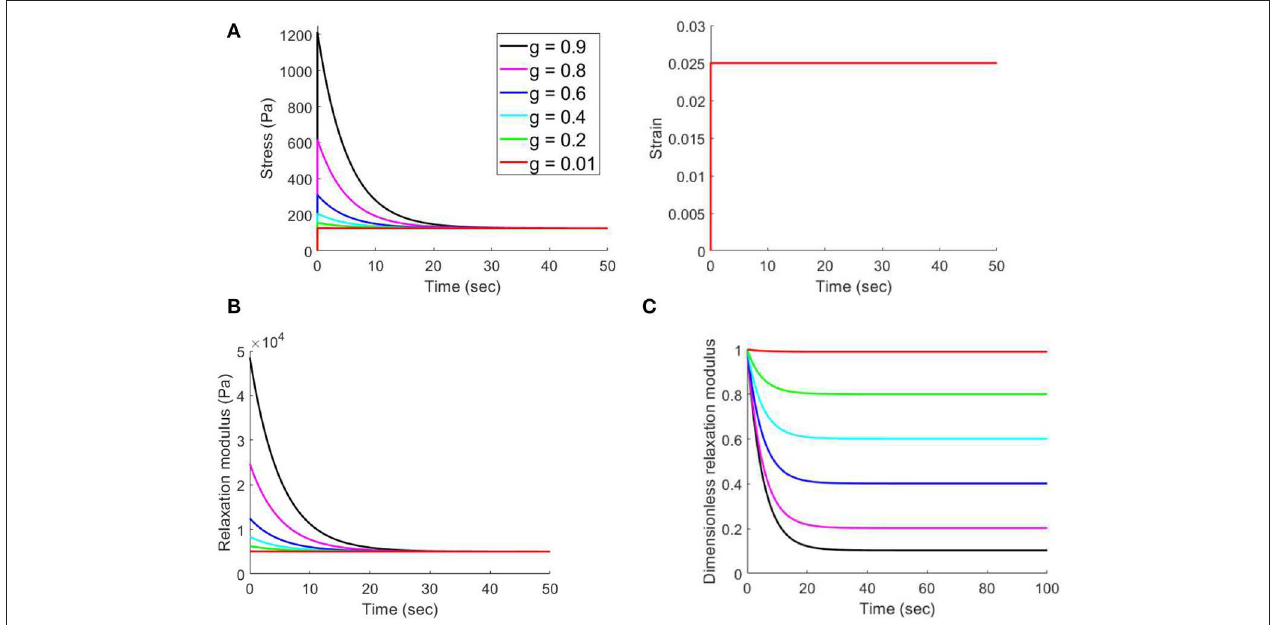
FIGURE 8 | (A) Stress and strain responses over time of different materials in the group 3 during the stress relaxation test. (B) Corresponding relaxation moduli. (C) Corresponding dimensionless form of the relaxation moduli.